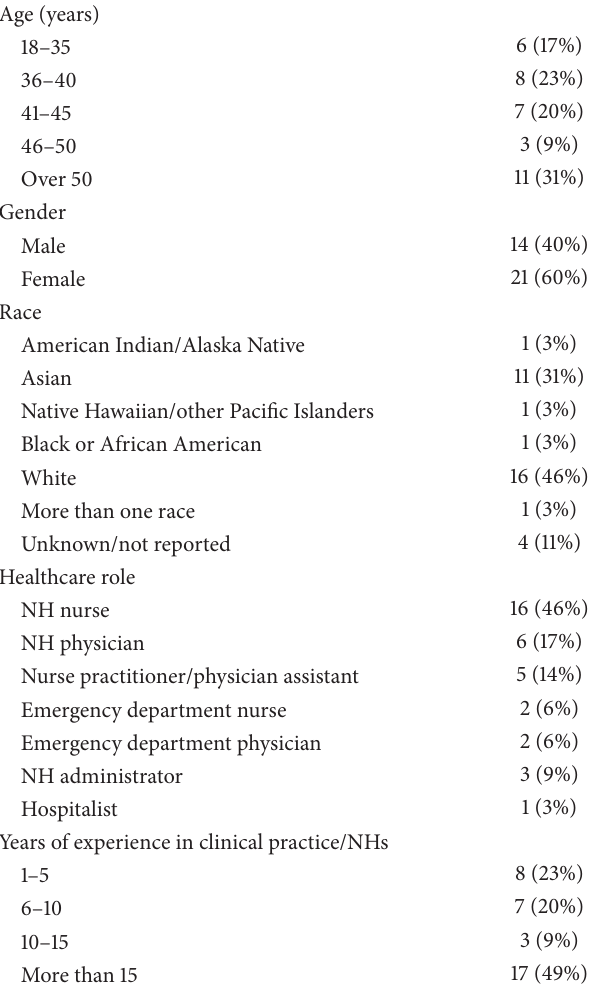
Table 1: Demographics and characteristics of provider focus